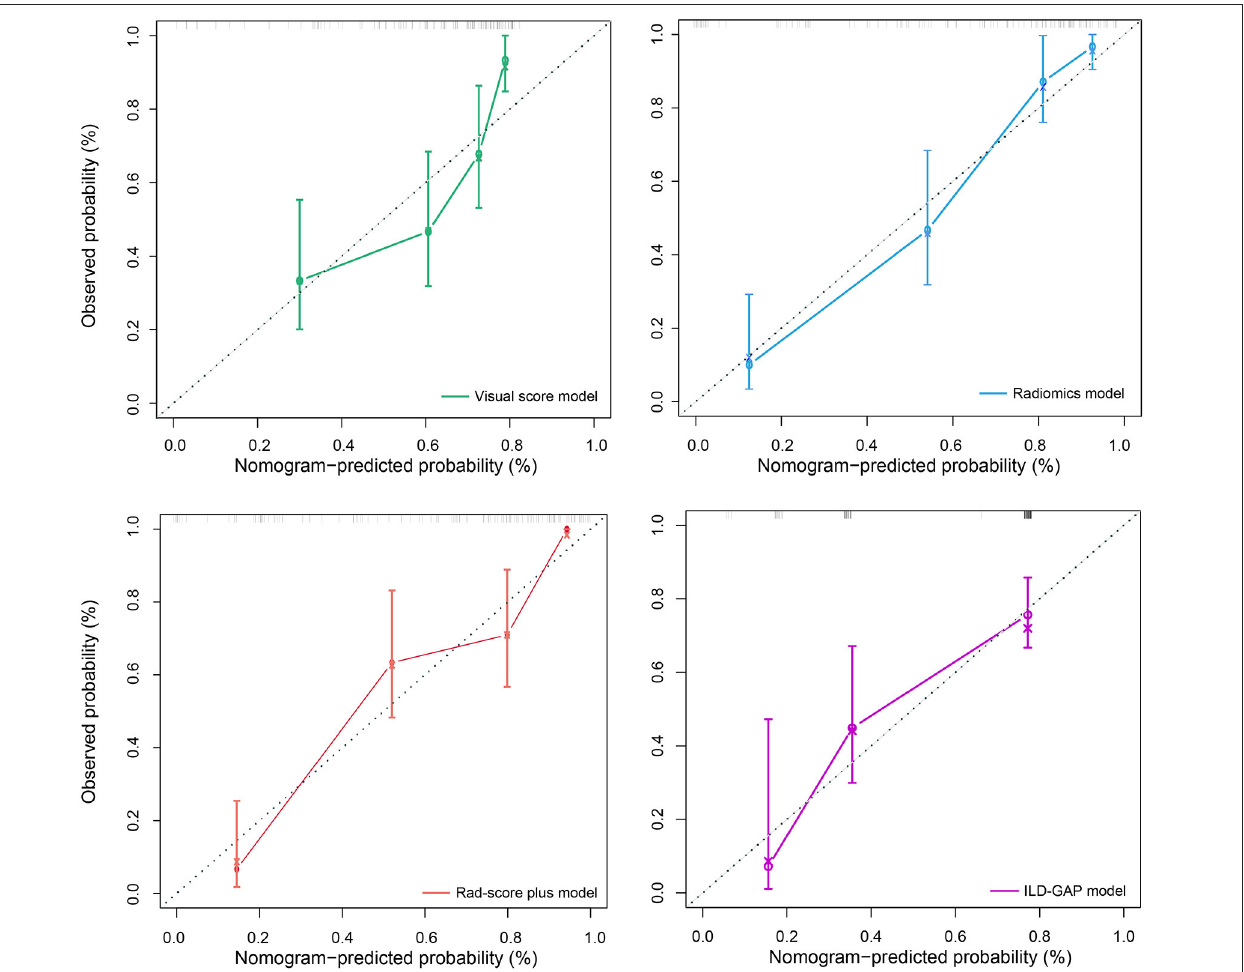
FIGURE 4 | Decision curve analysis for ILD-GAP model, visual score model, Radiomics model, and Rad-score plus model. The concept of population net benefit (NB) is fundamental to decision curves (measured in the y-axis) and referred to classification accuracy of a model. Suppose high risk is defined as risk above some risk threshold R (x-axis), an intervention is recommended in such high-risk patients. The NB of using the risk model was calculated by the true-positive rate (TPRR), the proportion of cases with risk above risk threshold R, and the false-positive rate (FPRR), the proportion of controls with risk above risk threshold R. The horizontal dotted line at NB = 0 indicated a simple policy of no intervention to all patients (treat none); the gray curve in the plot depicted the NB of another simple policy: the intervention was recommended to everyone regardless of risk. In our result, the Rad-score plus model had the highest net benefit compared to others, almost across the full range of threshold